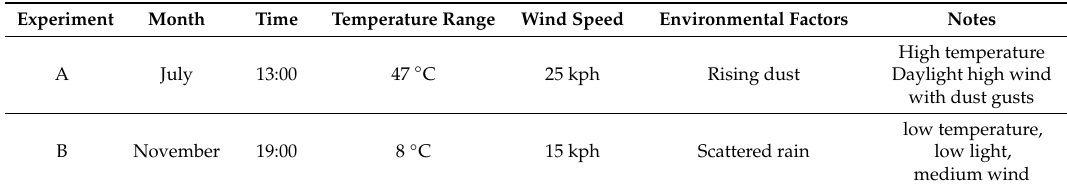
Table 1. Experimental